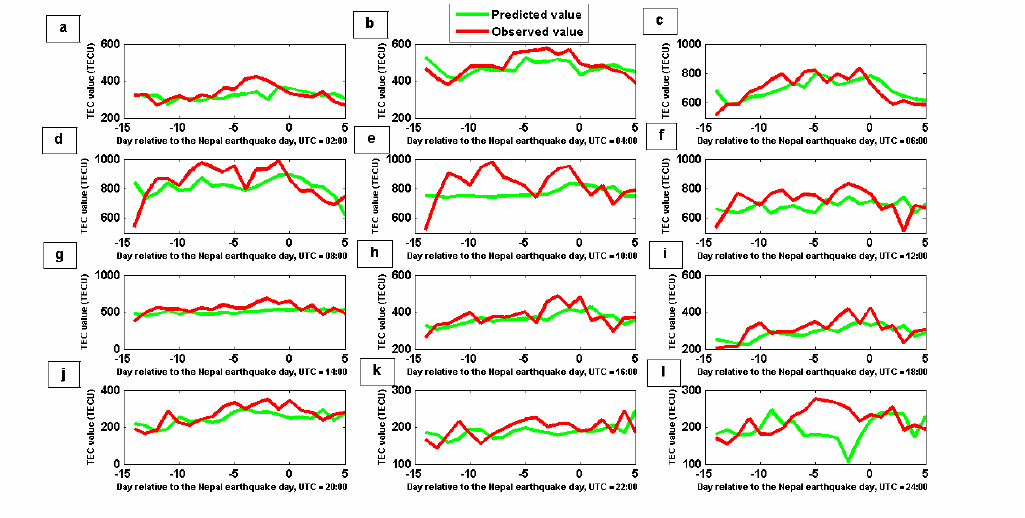
Fi g. 6. a) through l) Variations of the observed (red curve) and predicted (green curve) TEC values obtained from LSSVM method during at different universal times. The X-axis represents the day relative to the Nepal earthquake day.